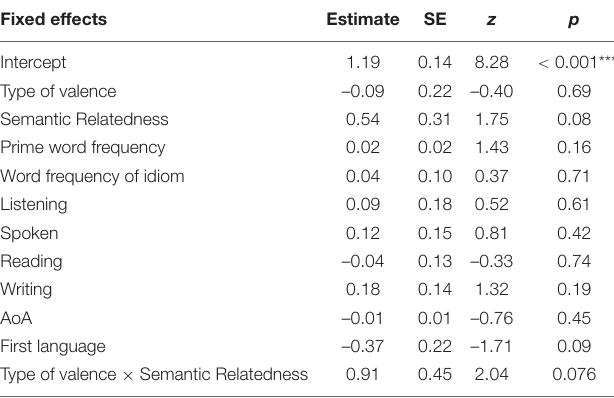
TABLE 10 | Model parameters in the mixed-effect model for ACC in Experiment